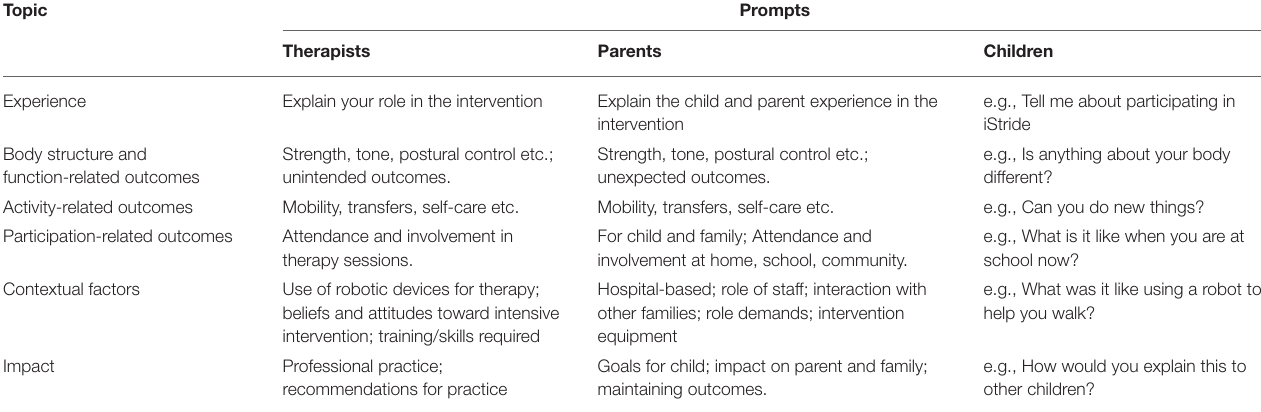
TABLE 1 | Key topics and prompts in semi-structured interview